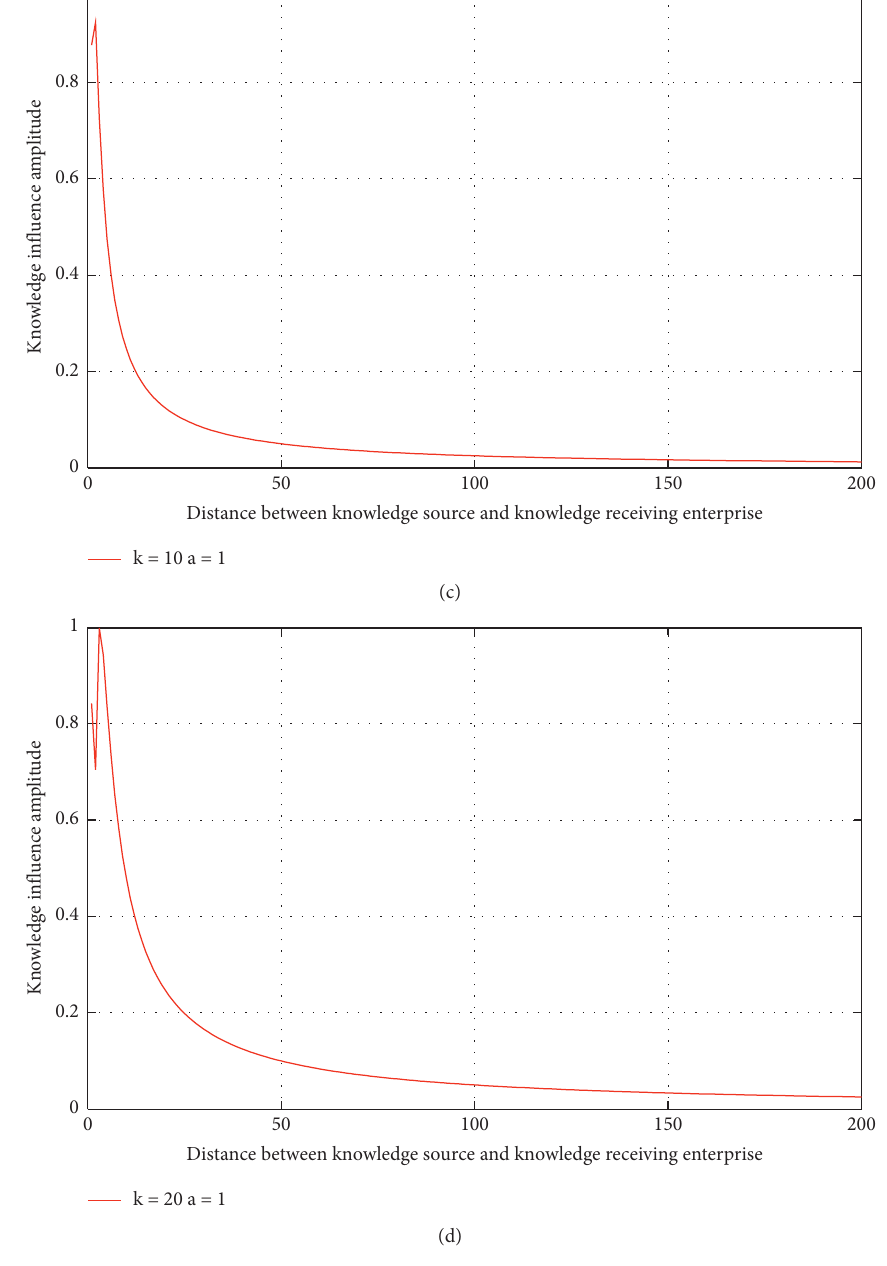
Figure 9: Distributions of the influence amplitude in the knowledge field when a � 1 and k � 2 , 5 , 10 ,